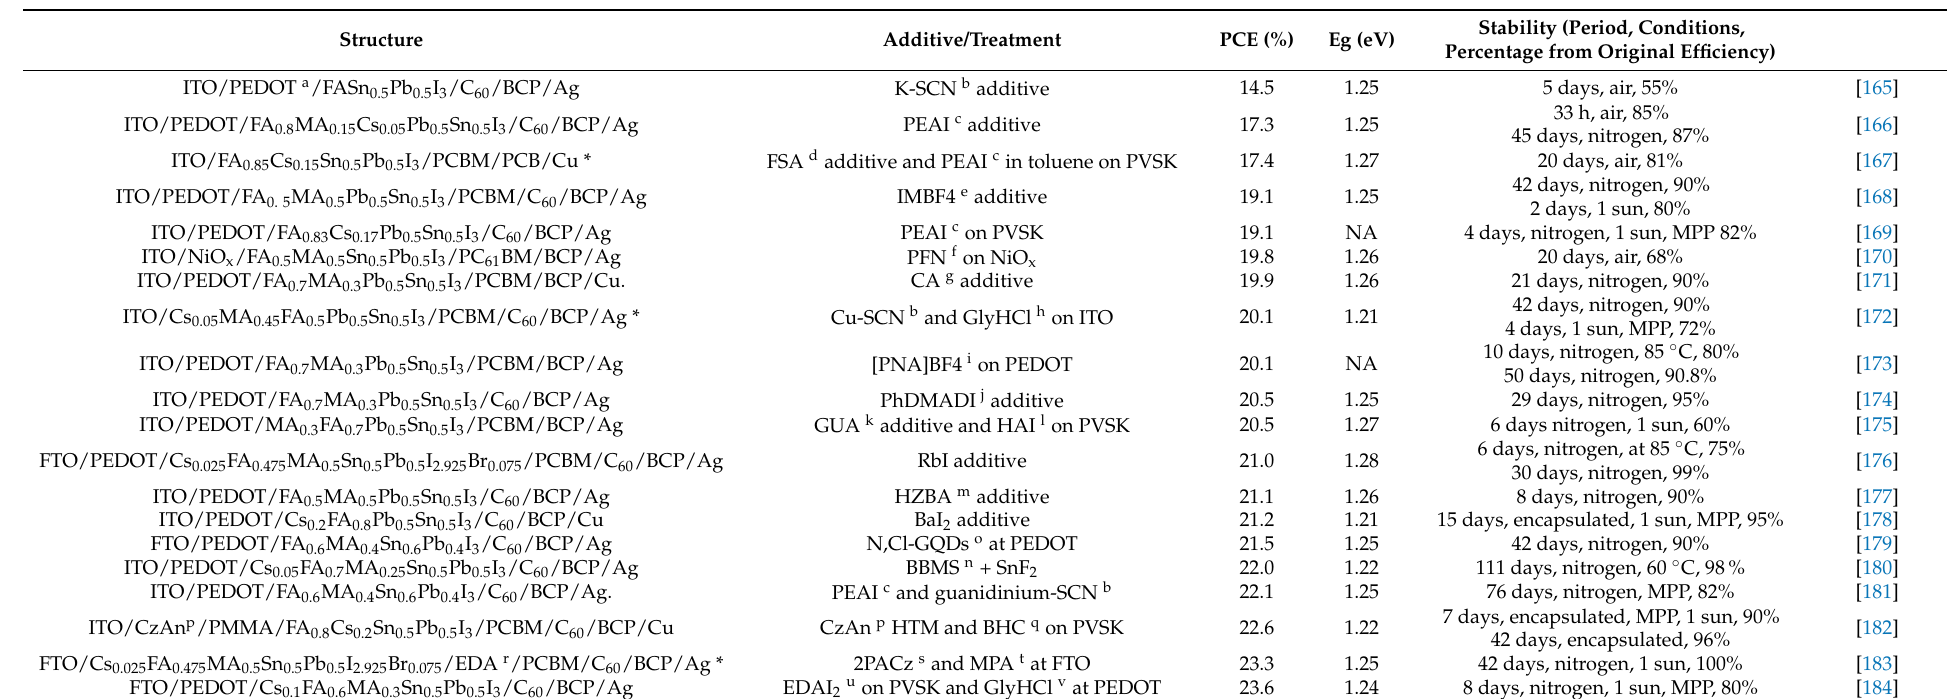
Table 3. Additives/surface and Pb ≤ 50%. Best-performing TPSCs with lead content ≤ 50% with perovskite surface/interface modifiers or perovskites additive reported in 2021 and